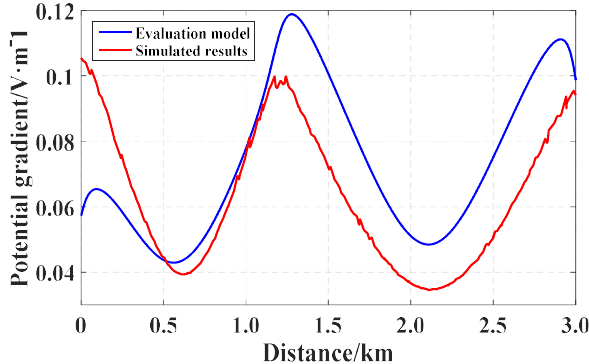
Figure 8. Surface potential gradient simulated by COMSOL 5.2.